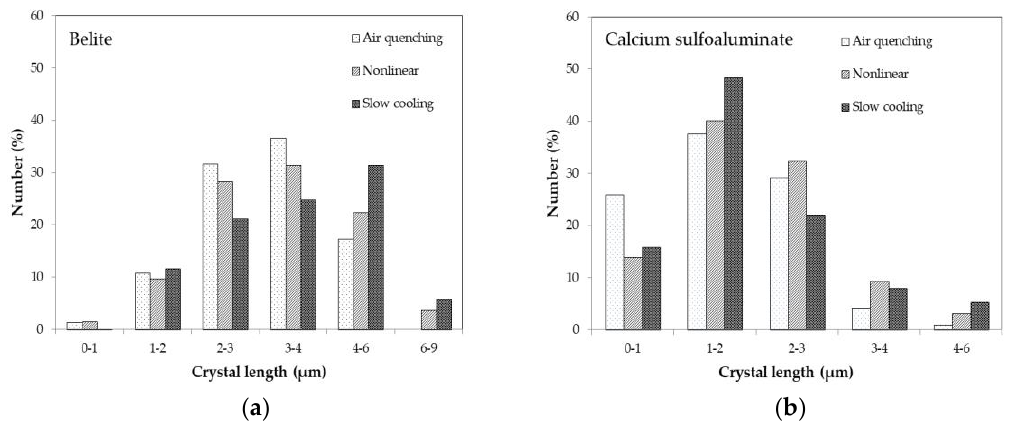
Figure 6. Belite ( a ) and calcium sulfoaluminate ( b ) crystal size distributions under different cooling regimes.